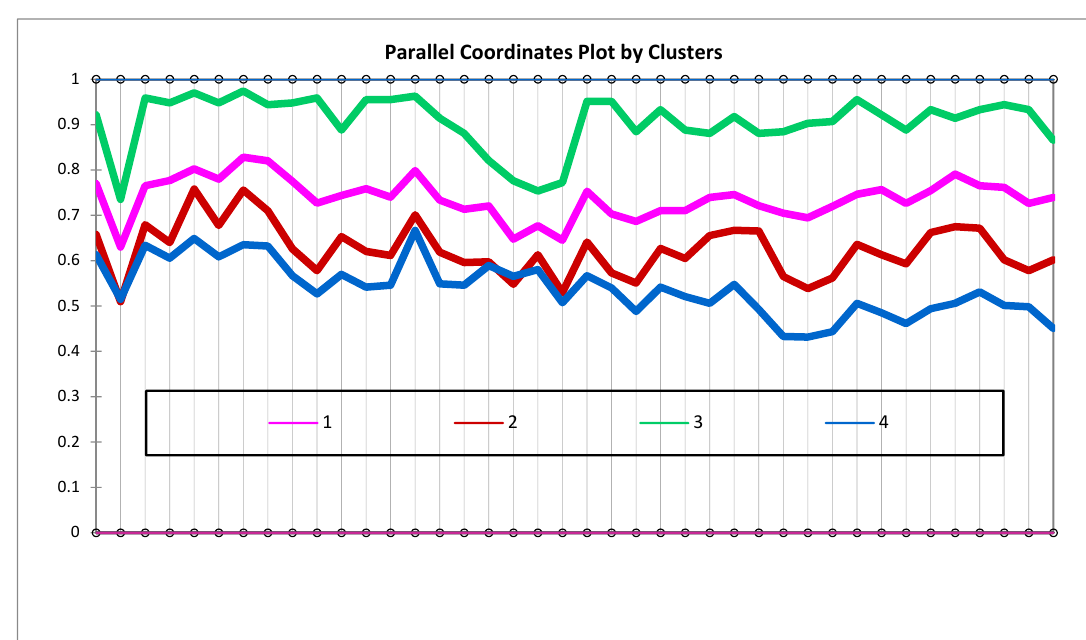
Figure A1. Dendrogram of participant profiles. Figure A1.